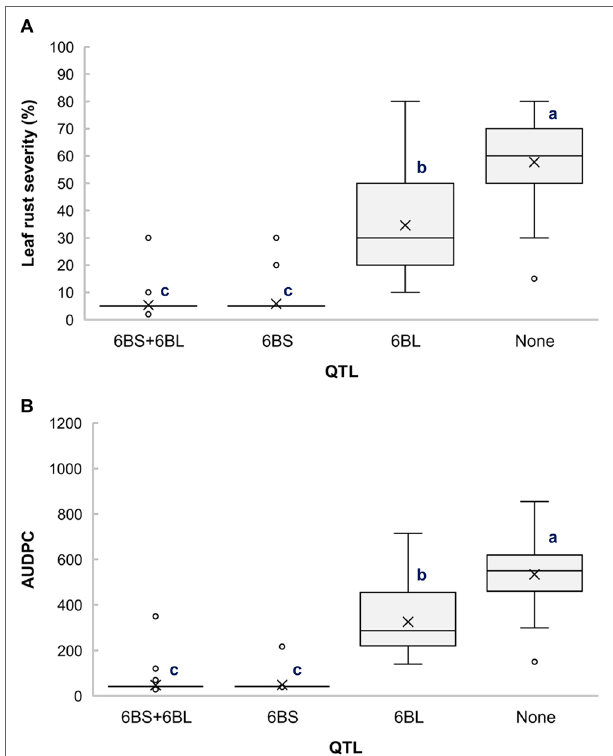
FIGURE 2 | Boxplots illustrating the effects of QLr.usw-6BS and QLr.usw- 6BL on (A) LRS and (B) AUDPC in the Gaza/ATRED #2 population. The QTL effects are shown in isolation and in combination. Means with the same letter are not significantly different from one another at P < 0.05.